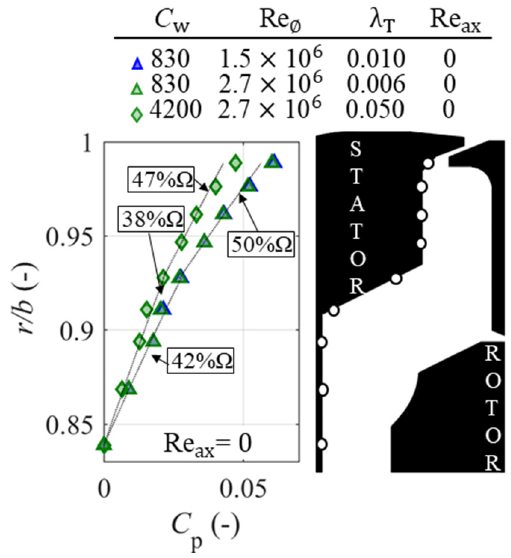
Figure 3. Cavity radial pressure distribution.